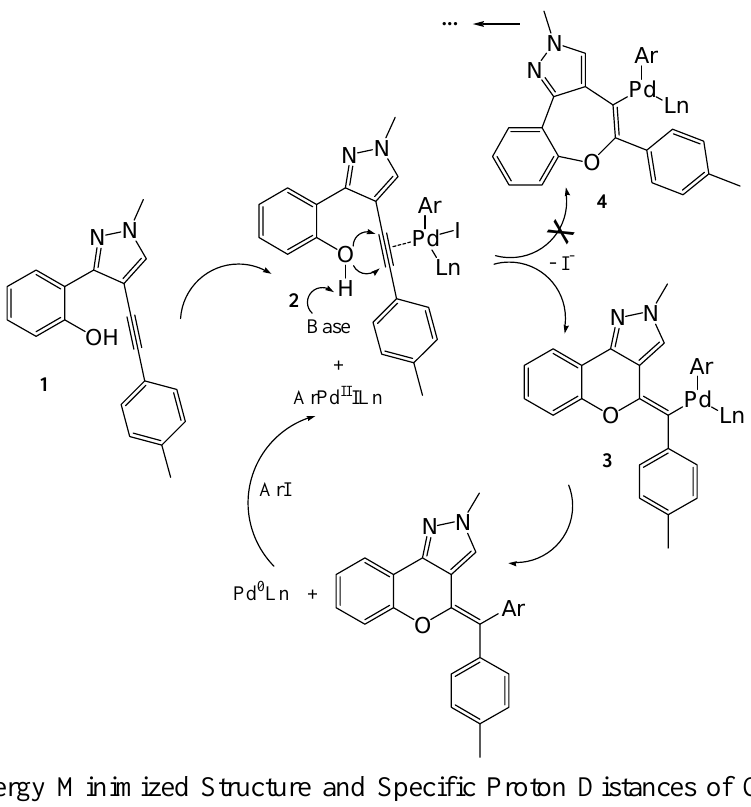
Figure 2. Possible Mechanism of the Palladium Catalyzed Cyclization.